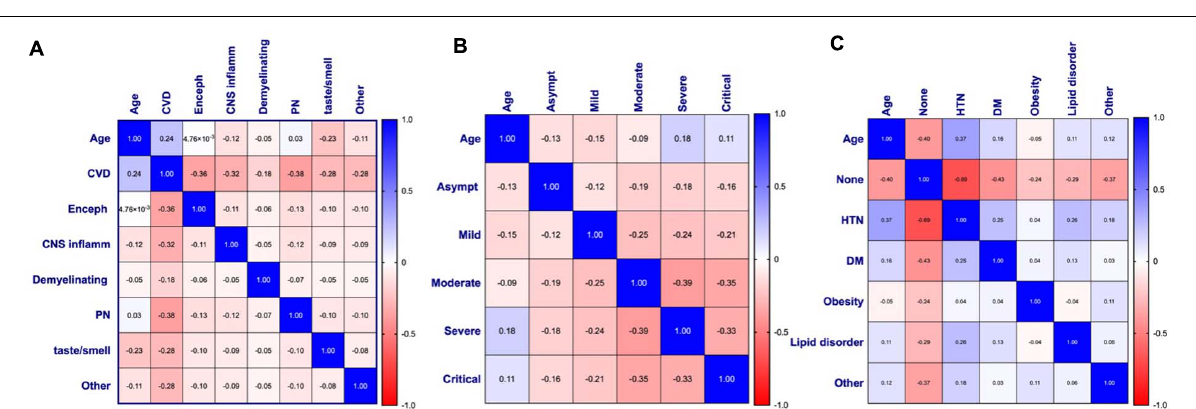
FIGURE 5 | Simple linear regressions demonstrating the effect of age on (A) cerebrovascular disease, (B) encephalopathy, (C) peripheral neuropathy, (D) CNS inflammatory disease, (E) demyelinating disease, (F) taste and/or smell disorders, and (G) other non-specific neurological symptoms and their relationships with age (years) for patients with COVID-19 ( n = 510).